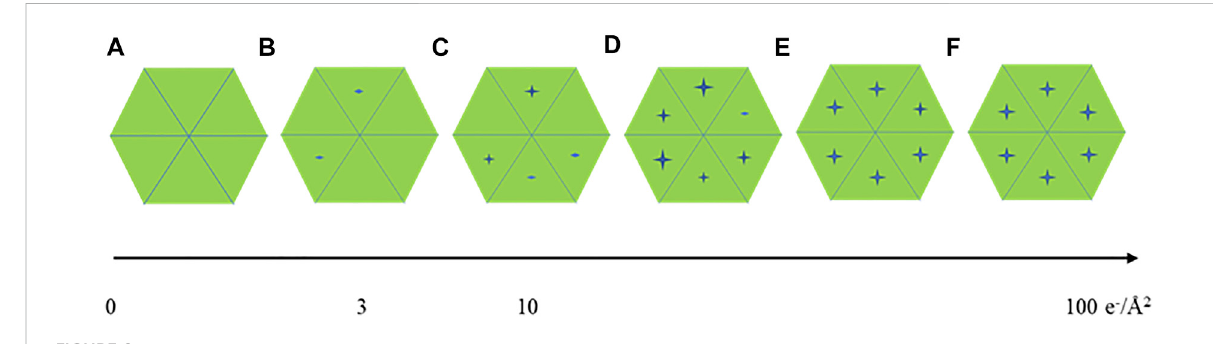
FIGURE 2 A cartoon illustration of a hexameric complex being gradually damaged by electron dose accumulation from (A – F)